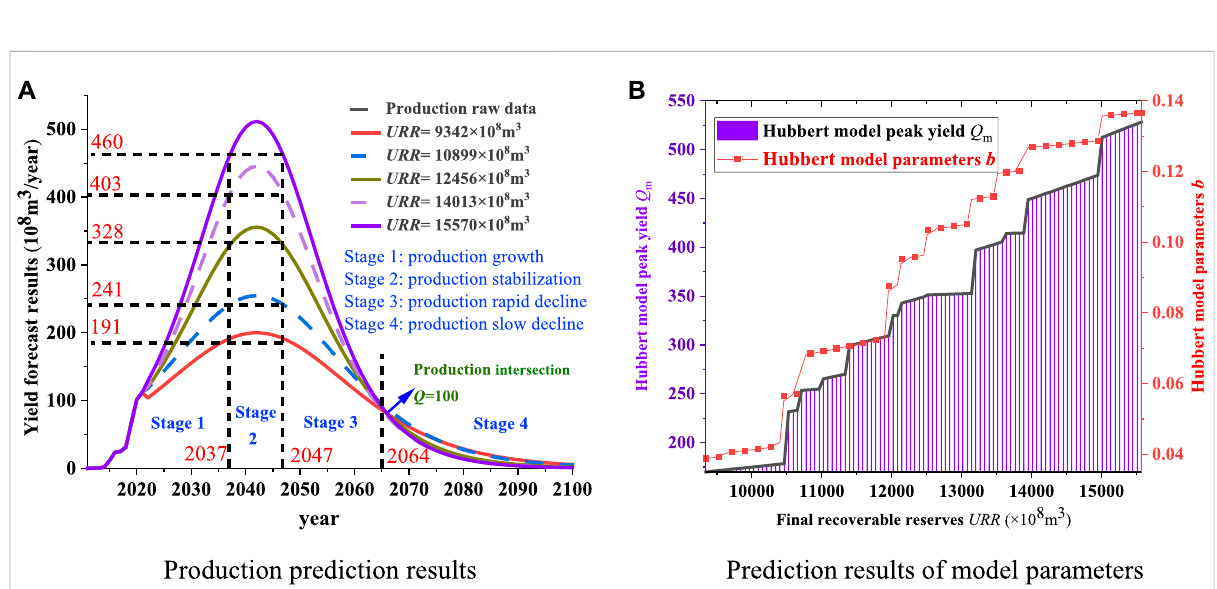
FIGURE 6 Prediction results of shale gas production based on Hubbert model. (A) Production prediction results. (B) Prediction results of model